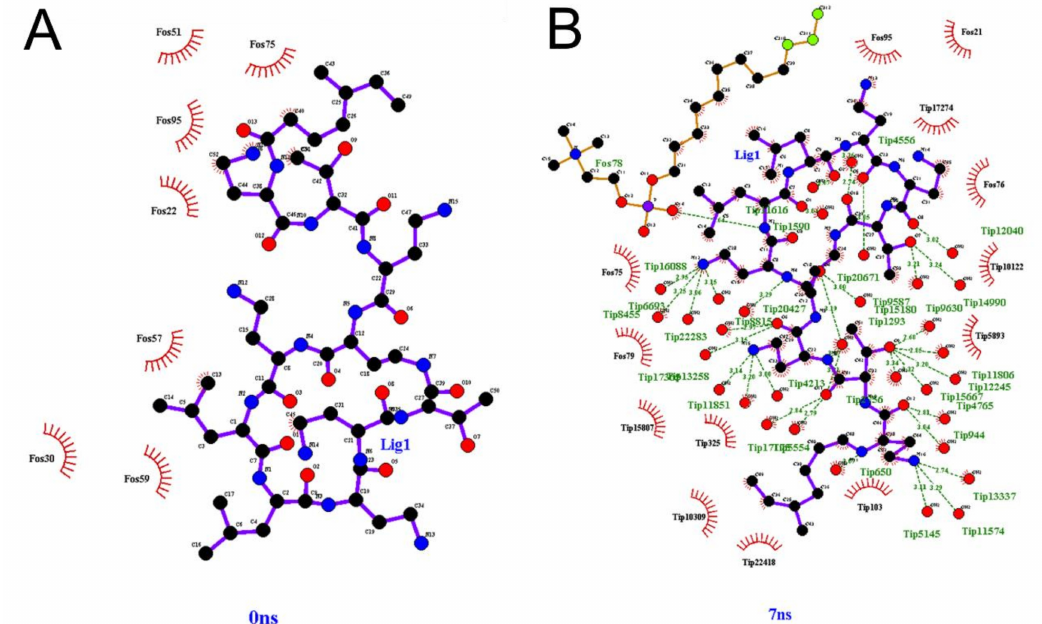
Figure 5. Interaction between CST and DPC micelle hydrated atoms ( A ) at 0 ns. ( B ) At 7ns. Fos: DPC molecule. Lig: CST. Tip: water